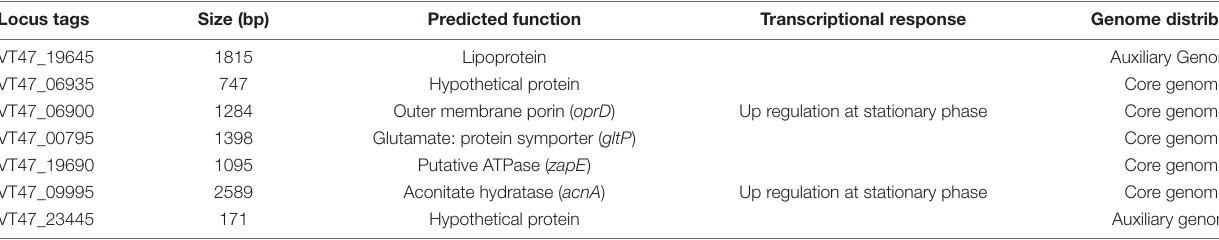
TABLE 5 | Nematicidal genes identified by transposon insertion mutant library screening. Locus tags